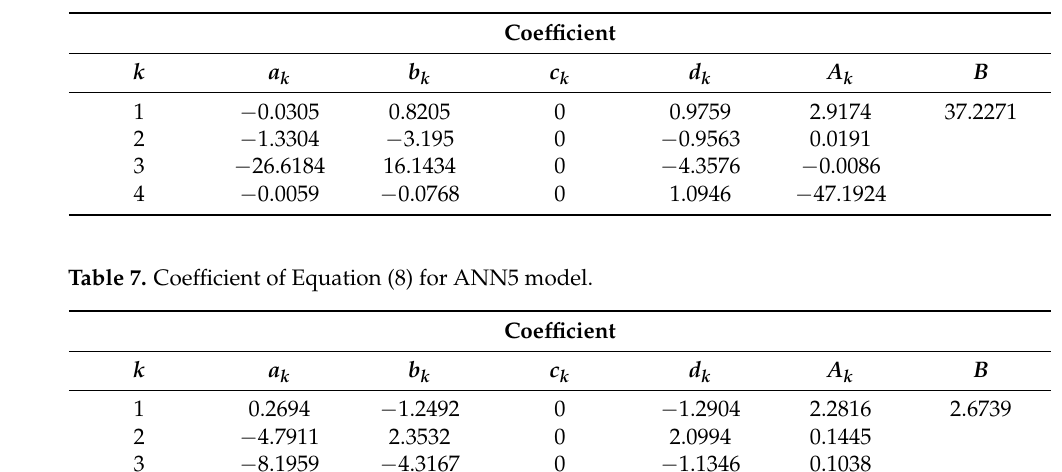
Table 6. Coefficient of Equation (8) for ANN4 model.